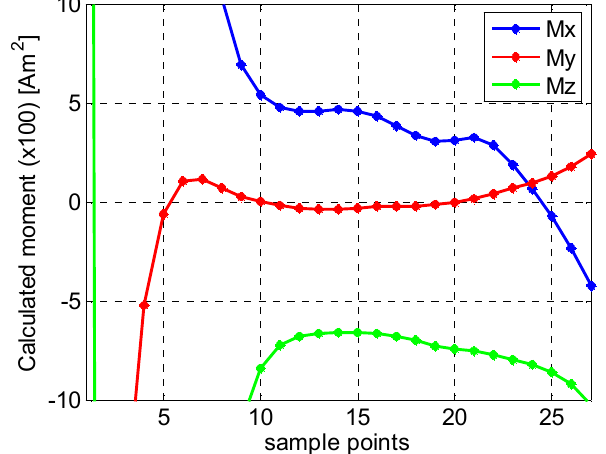
Figure 5. The calculated magnetic moment after the first round of